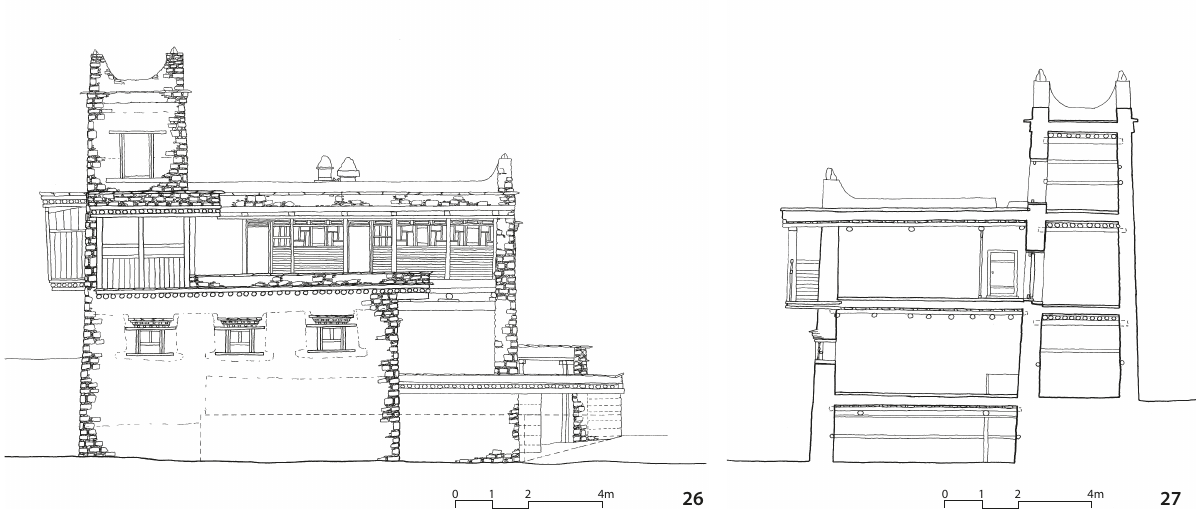
Figure 26 West elevation of the farmhouse in Gyalrong (Source: the authors). Figure 27 Section A-A through the tower (Source: the authors).